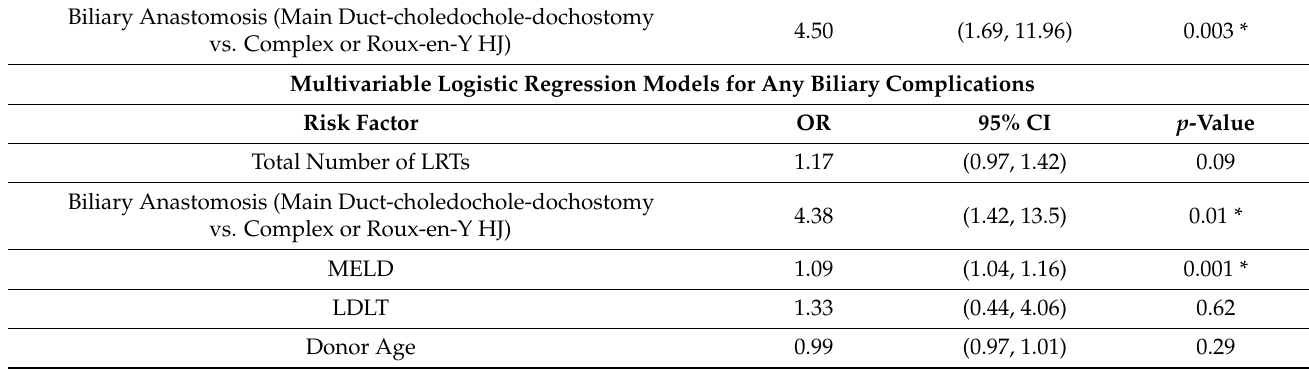
Table 6. Logistic Regression Models for Any Biliary Complications Unadjusted Logistic Regression Models for Any Biliary Complications vs. Risk Factor